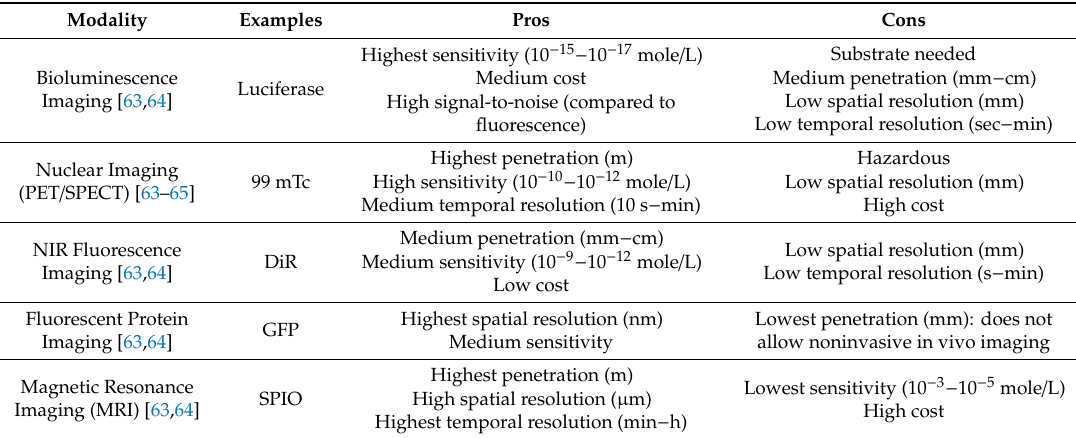
Table 2. Comparison of bioimaging